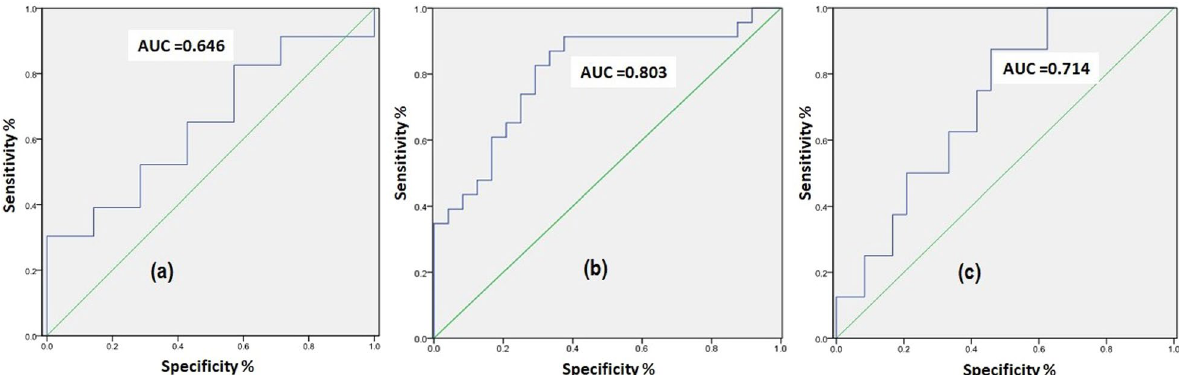
Fig. 3 Roc curves for sensitivity and specificity of GSDMD for differentiating between a MPE from TBPE, b MPE FROM PIPE, and c TBPE from PIPE